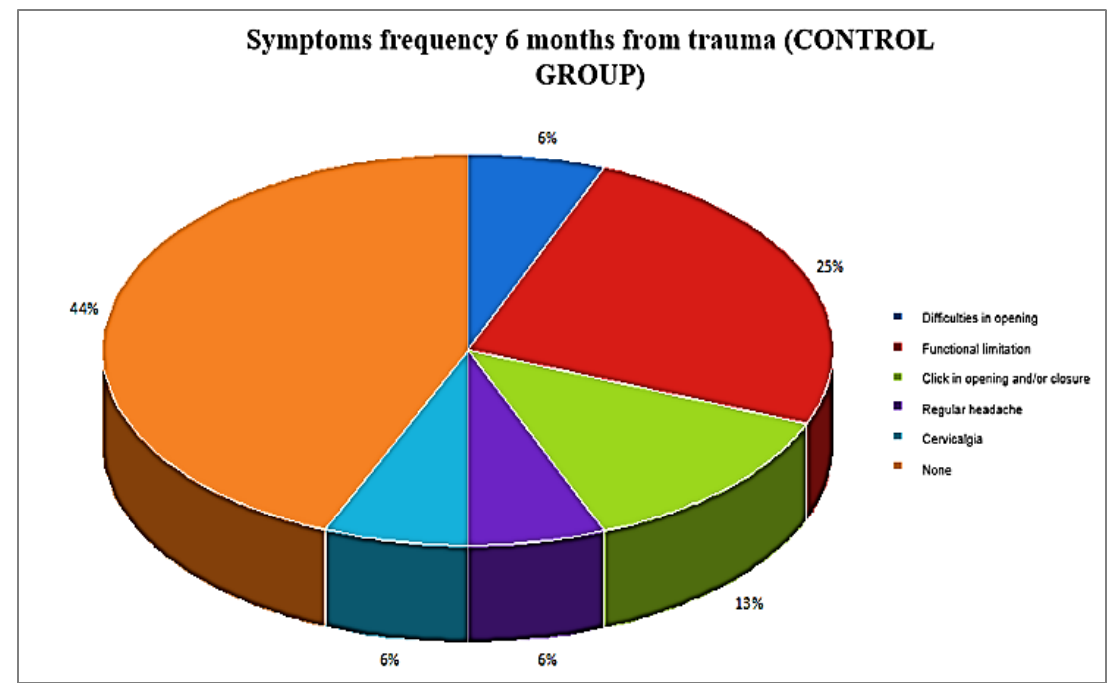
Figure 4. Symptom frequency 6 months from trauma (control group).